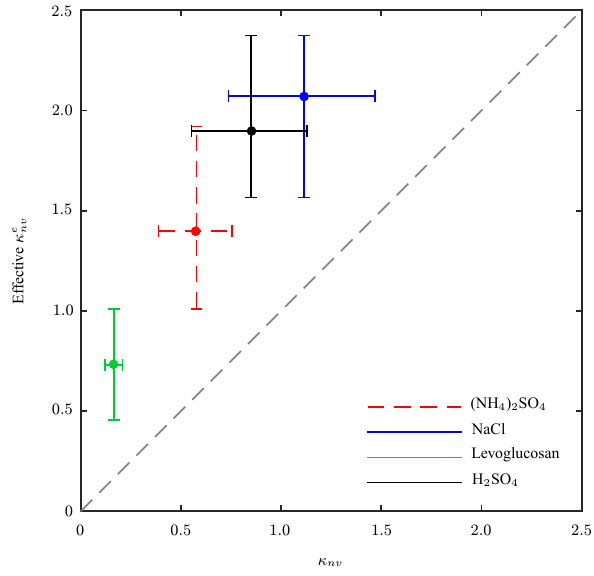
Figure 6. Effective hygroscopicity, κ e nv plotted against the hygro- scopicity of non-volatile compounds, κ nv . The dots show the mean values and the error bars represent the 16th and 84th quantiles. Am- monium sulfate is shown in red with dashed error bars, sodium chlo- ride is shown in blue, levoglucosan is shown in green and sulfuric acid is shown in black. The dashed grey line shows the 1 : 1 line.